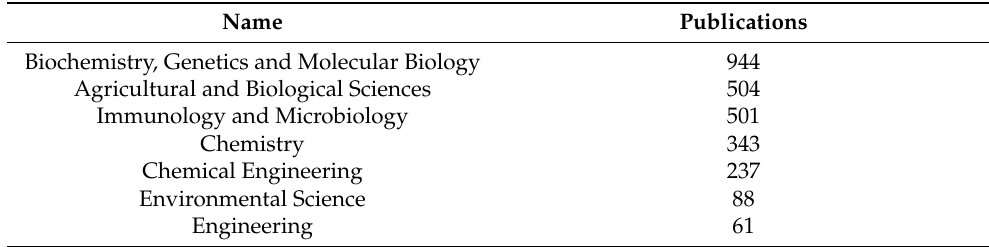
Table 1. Major research categories (Scopus) related to pullulan-degrading enzymes.